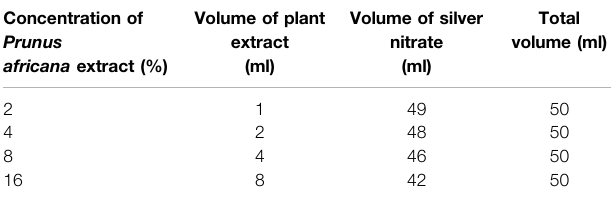
TABLE 1 | Concentration of plant extract, volume of plant extract, and volume of silver nitrate used to green synthesize AgNPs. Concentration of